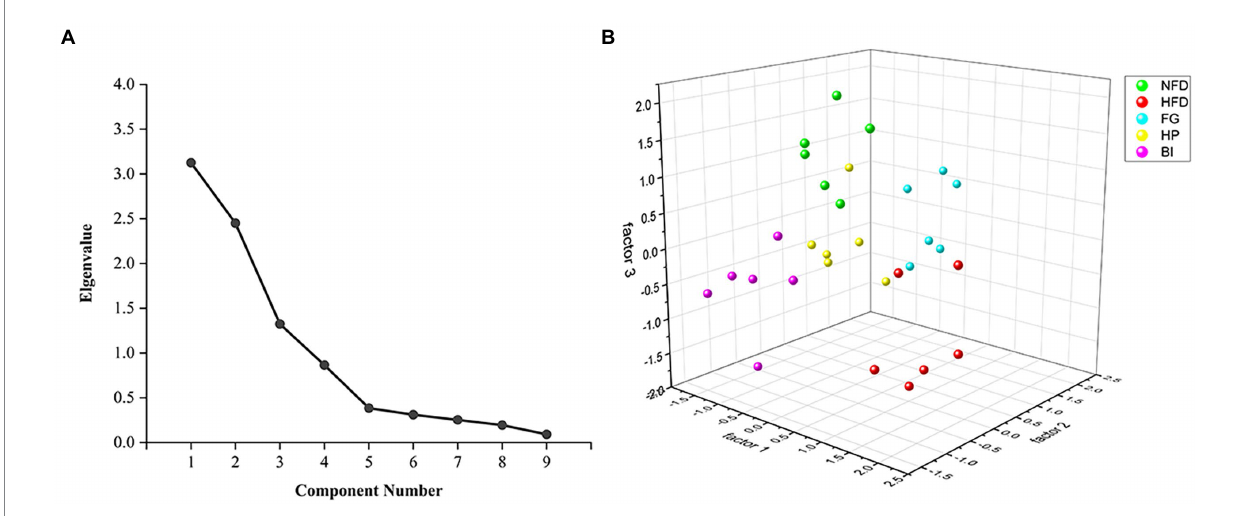
FIGURE 4 Factor analysis of biochemical indexes. (A) Scree plot depicting the eigenvalues of the factors extracted by factor analysis using biochemical indices as variables. (B) Scatter plot of FG, HP, and BI on the effects of hyperlipidemia related factors based on factor analysis.